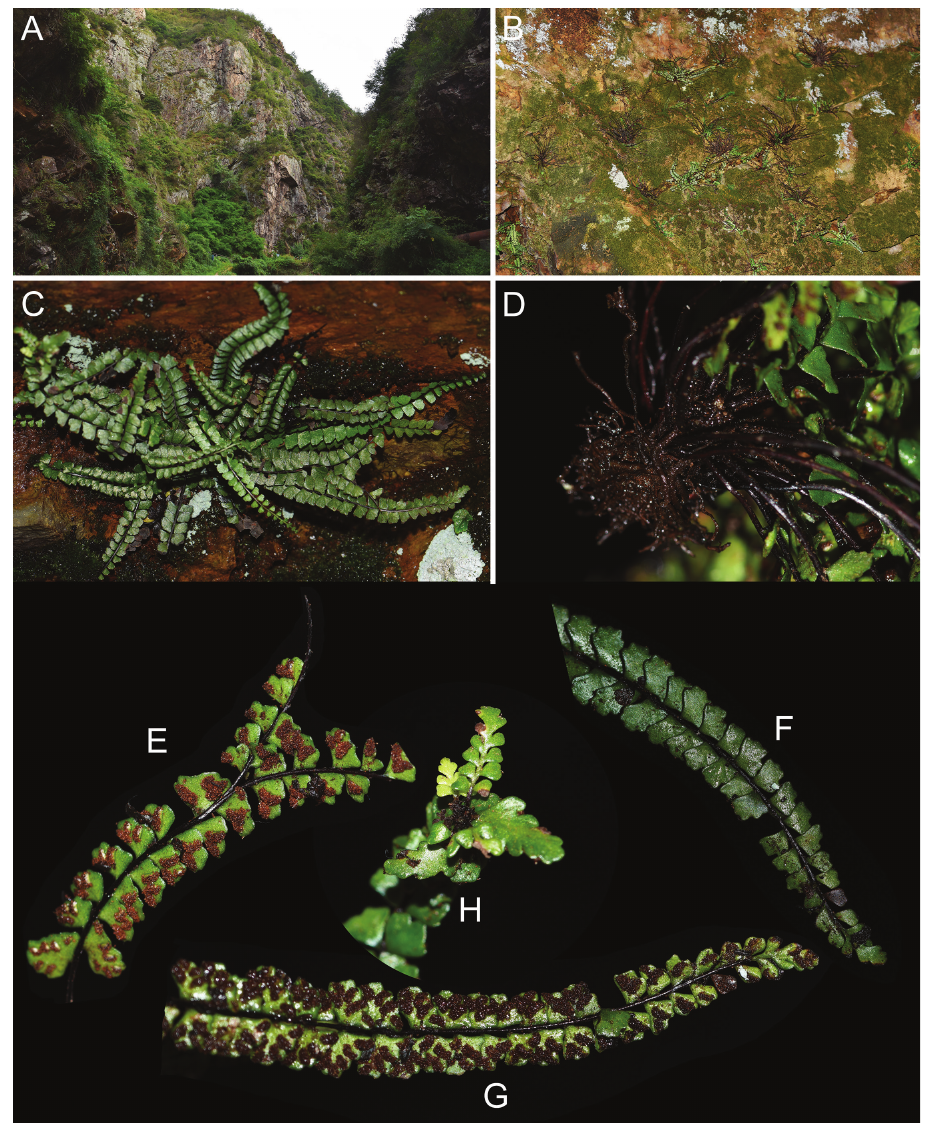
Figure 1. Asplenium jiulianshanense K.W.Xu & G.L.Xu A, B habitat where the new species was dis- covered C habit D rhizome and roots E irregular branch of lamina F adaxial view of portion of lamina G abaxial view of portion of fertile lamina H frond with a gemma at the distal end of the